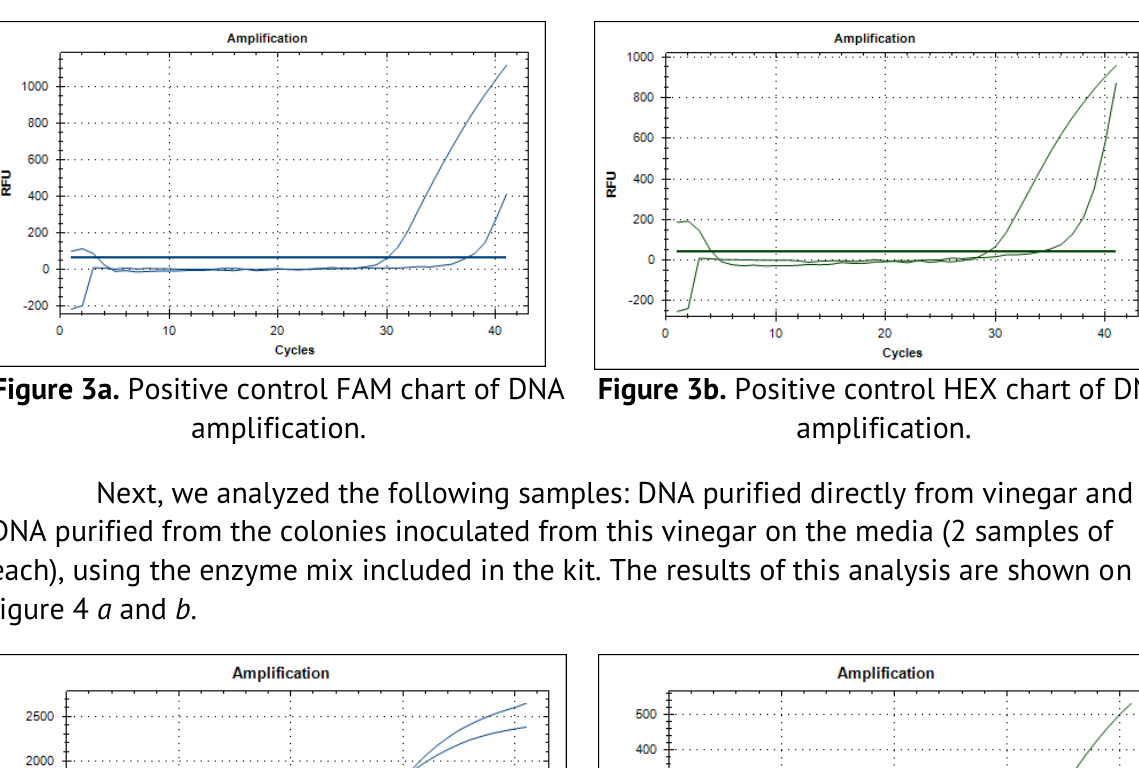
Figure 3b. Positive control HEX chart of DNA amplification.